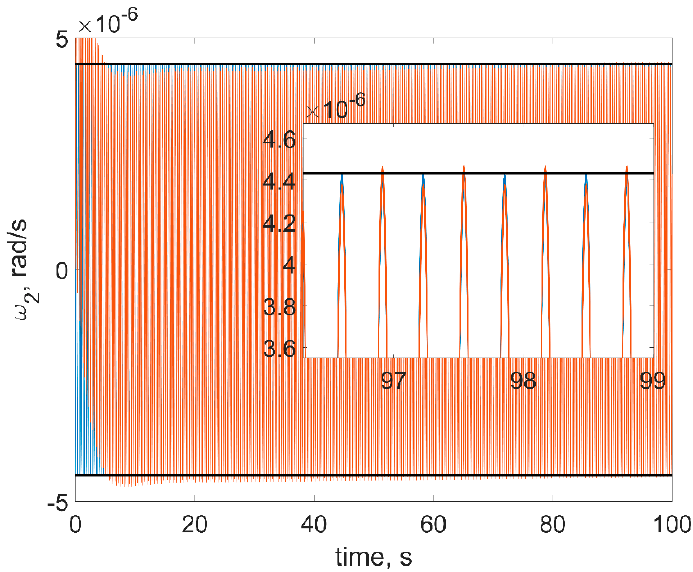
ω for static imbalance case (red is numerical solution, blue is approximate Figure 12. Evolution of Figure 12. Evolution of ω 2 for static imbalance case (red is numerical solution, blue is approximate 2 solution, horizontal lines are the estimations). solution, horizontal lines are the